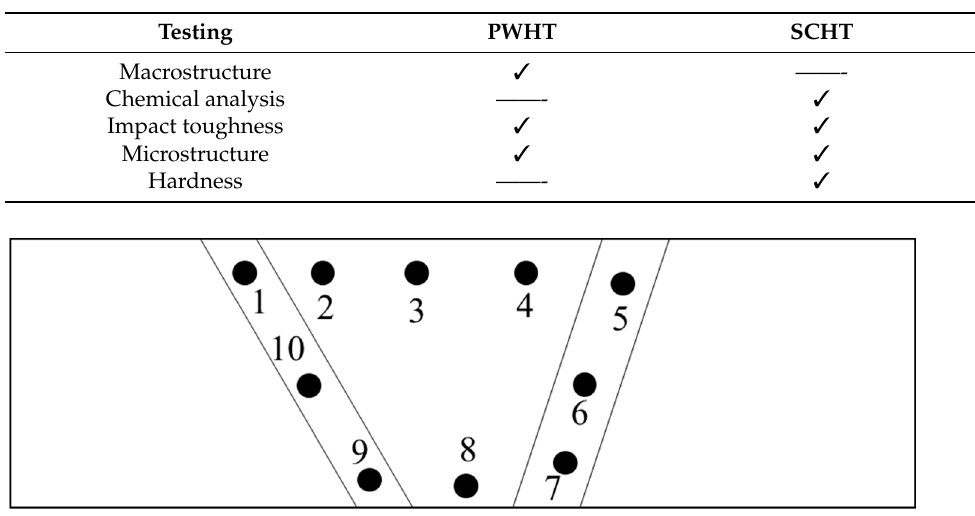
Figure 4. Hardness indentation across the weldment–SCHT condition.